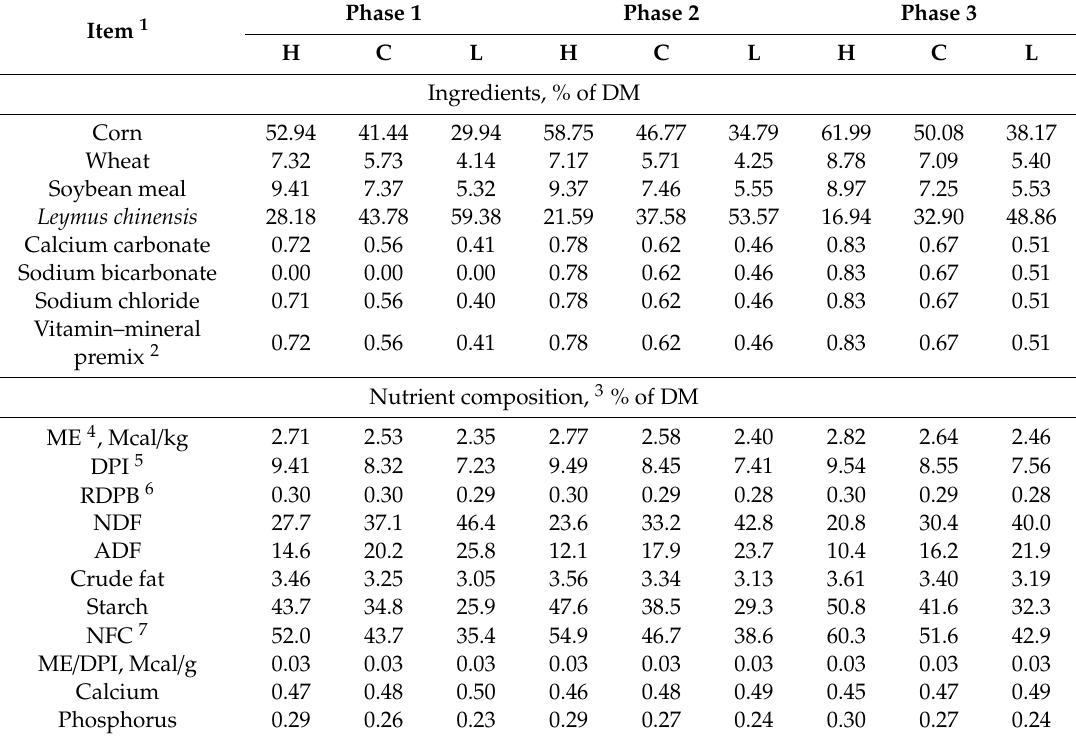
Table 1. Ingredients and Nutrient Composition of the Experimental